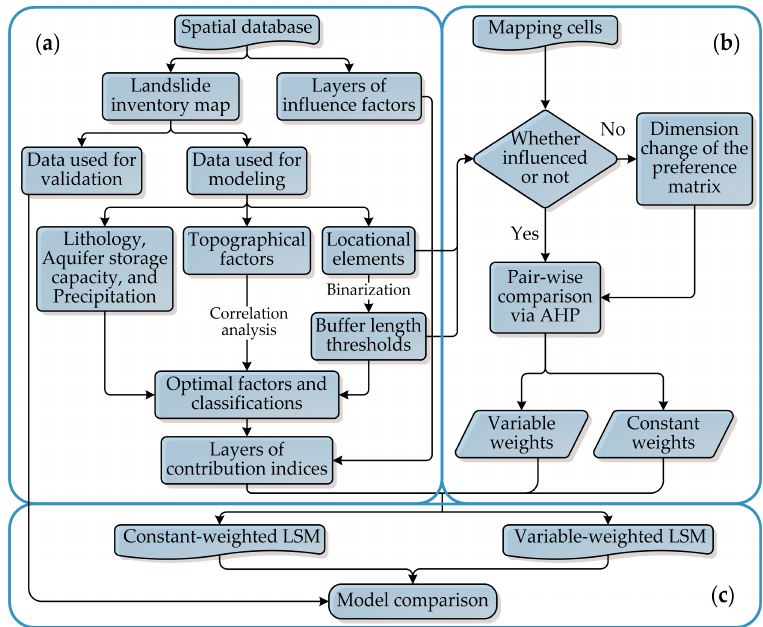
Figure 2. Procedural flow chart adopted in this paper: ( a ) data processing, which includes classification, correlation analysis, and the determination of the contribution index; ( b ) weighting according to the different locations of mapping cells based on the improved AHP; and ( c ) landslide susceptibility mapping and model comparison.